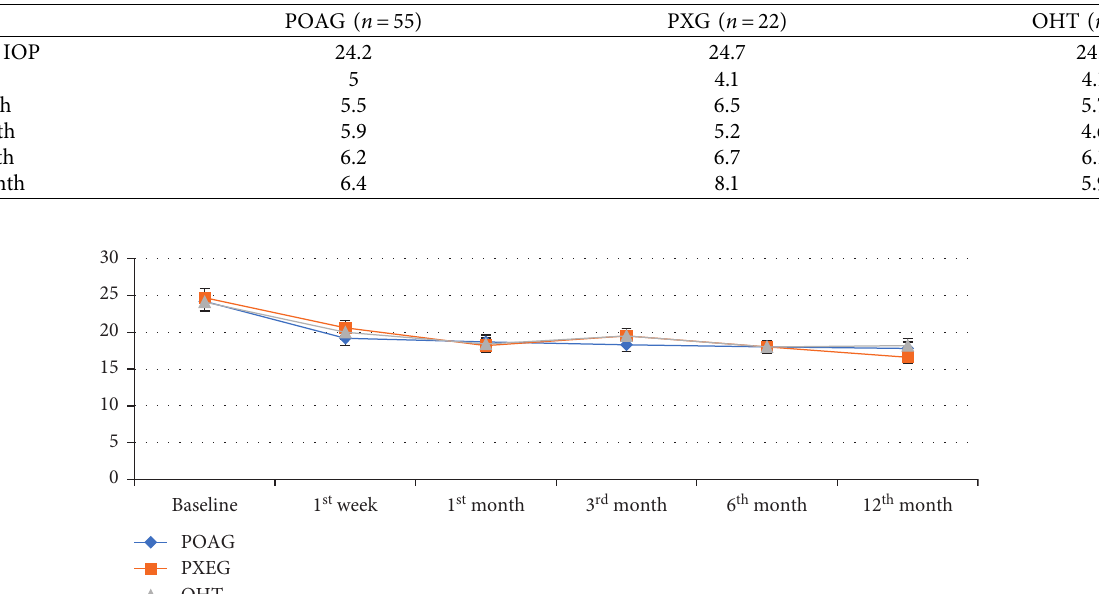
Figure 3: Mean IOP before and after SLT for POAG, PXG, and OHT at different follow-up visits, Menelik II Hospital,